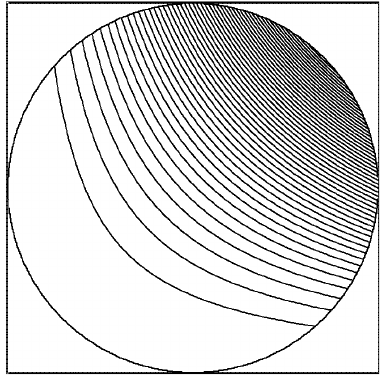
Figure 9. Equidistant lines of equal head for the quasi-circular area.